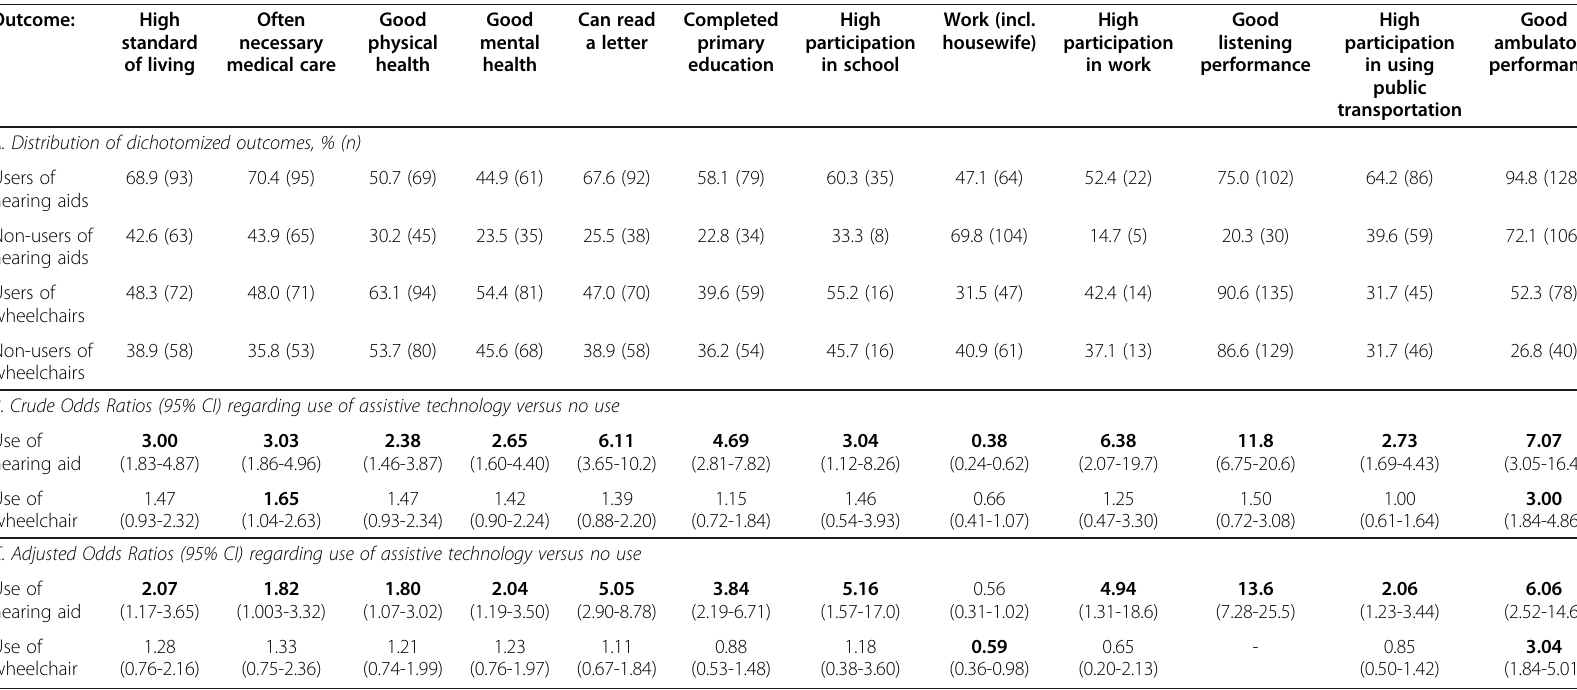
Table 4 Distribution of dichotomized outcomes (A), crude odds ratios (B), and adjusted odds ratios (C)